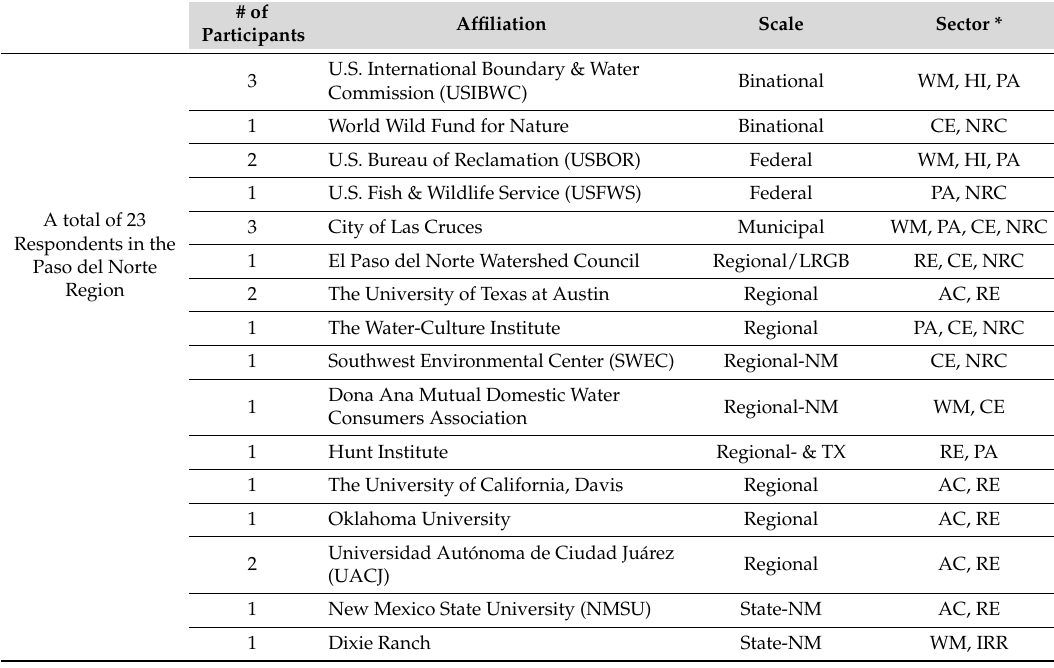
Table A4. A total of 23 Respondents in the Paso del Norte